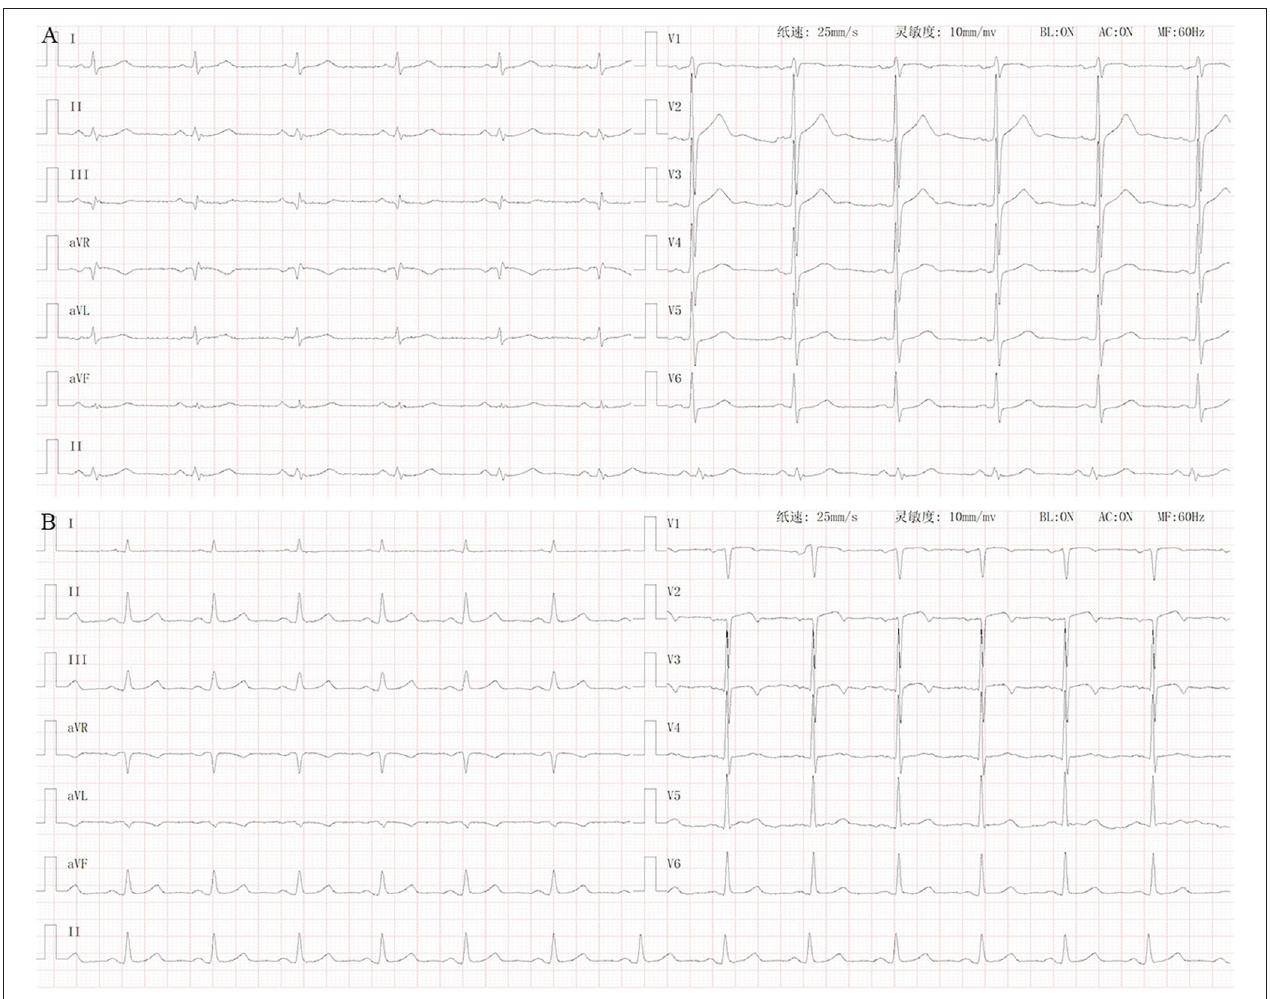
FIGURE 1 | Normal ECG vs. ECG of patients with lung cancer with T wave changes. (A) Normal ECG. (B) ECG of lung cancer patients with T wave inversion or flattening (I, aVL, V3, V4, and